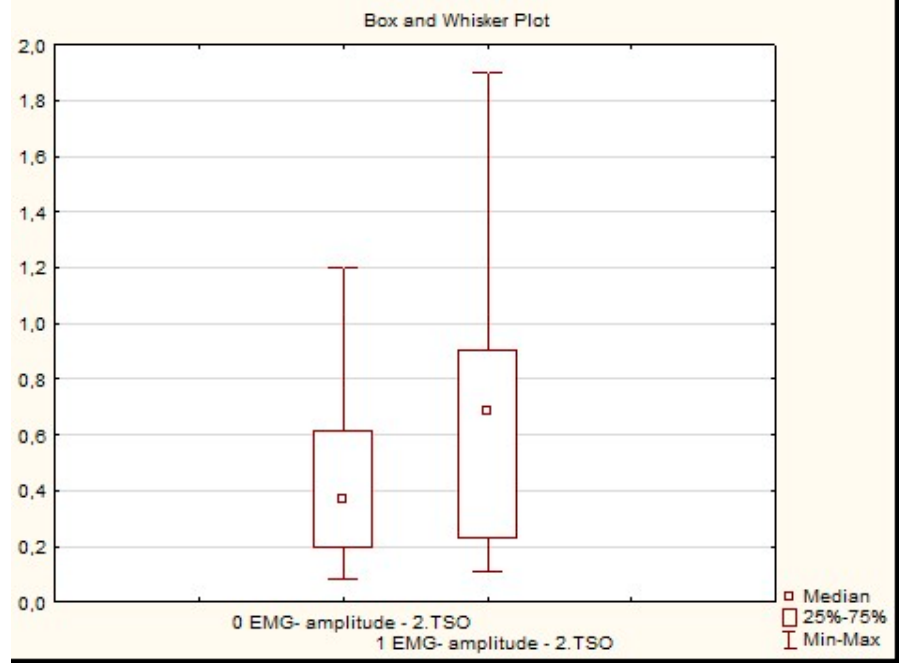
Figure 5. Comparison of the amplitudes in the second phase of toe-spread-out exercise in research group B (mV—millivolts, 2.TSO—the second phase of the toe-spread-out exercise, 0 EMG—examination before therapy, 1 EMG—examination after therapy).